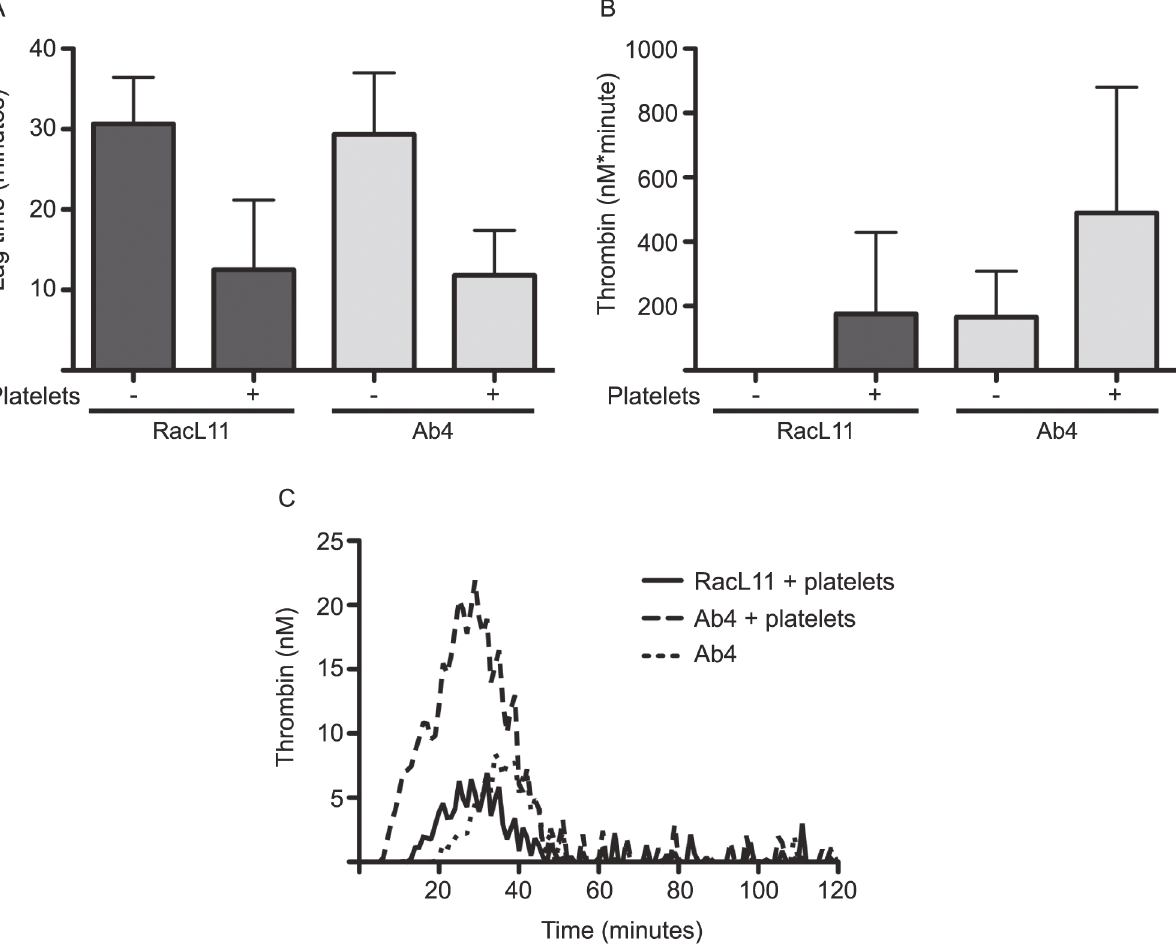
Fig 7. EHV-1 generates thrombin in equine plasma. Thrombin generation by purified virus (at amounts equivalent to 1 PFU/cell) was measured using calibrated automated thrombography in corn trypsin inhibitor (CTI)-containing citrate-anticoagulated platelet-derived microparticle-depleted equine plasma (CTI-MDP) with or without autologous platelets (1 x 10 5 /reaction). Data shown is lag time ( A ), total thrombin generated (nM * minute, derived from the area under the thrombogram curve) ( B ) and compilation thrombogram curves ( C , mean of 3 separate experiments). Addition of platelets shortened the lag time and boosted the total thrombin generated by both virus strains. Ab4, but not RacL11, generated small amounts of thrombin in CTI plasma alone. No thrombin was generated (lag time > 30 minutes, total thrombin generated 0 nM * minute) in negative controls (CTI-MDP with or without autologous platelets and CTI-MDP with RK lysate with or without